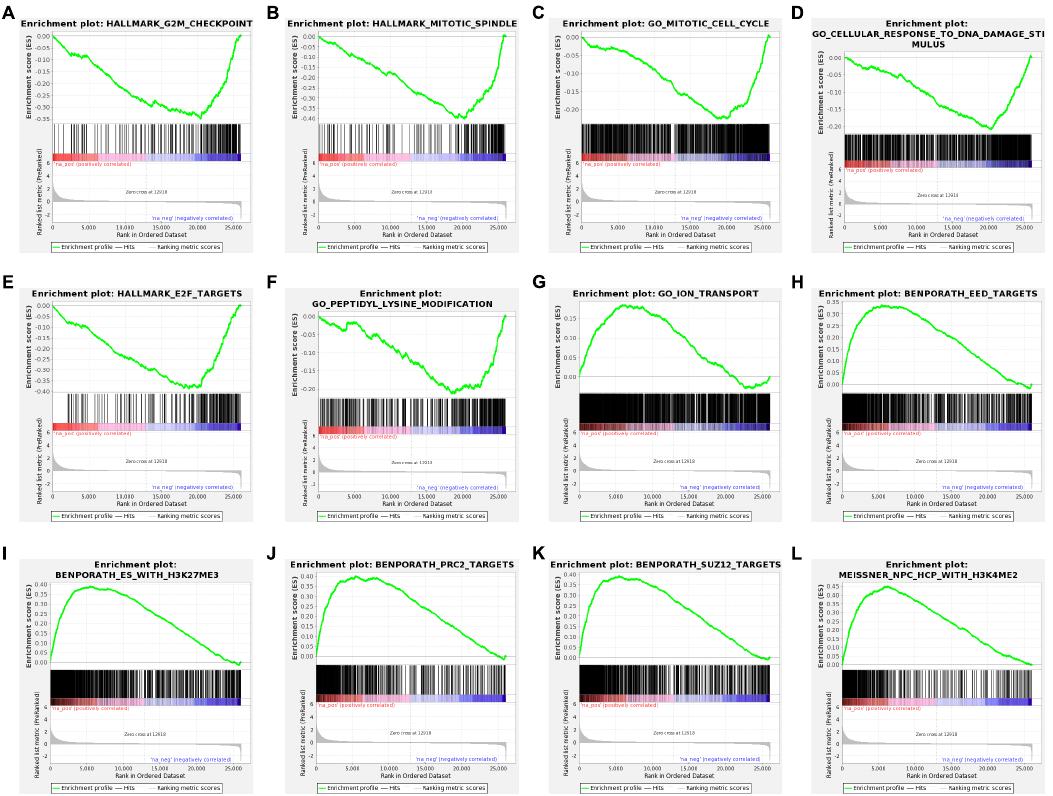
Figure 4. Enrichment plots showing significantly enriched gene sets (FDR < 0.05) in ranked gene list for samples treated with USP7797 for 24 h compared to those treated with DMSO vehicle control for 24 h. Running enrichment scores (ES) and locations of the members of the gene set in the ranked list of genes are shown for a dozen top representative molecular signatures from the Molecular Signatures Database (MSigDB) at https: // www.gsea-msigdb.org / gsea / msigdb. H: hallmark gene sets are shown in ( A , B , E ). C5: ontology gene sets are shown in ( C , D , F , G ). C2: curated gene sets are shown in ( H – L ). ( A – F ) show negative ES where the leading edge subset appears in the ranked list subsequent to the valley score. ( G – L ) show positive ES where the leading edge subset appears in the ranked list prior to the peak score. Genes 2020 , 11 , x FOR PEER REVIEW